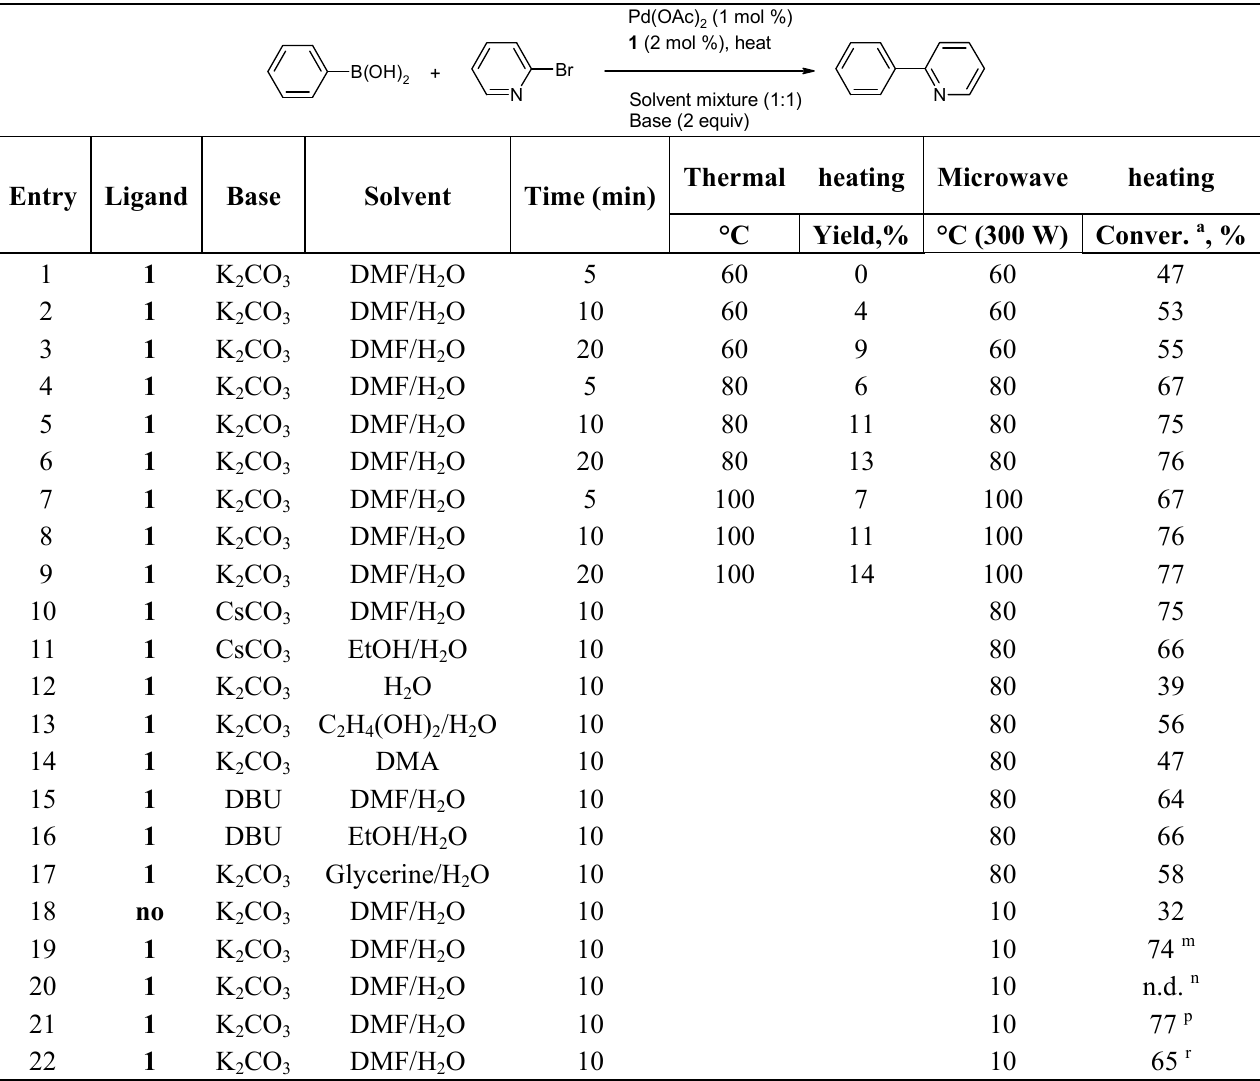
Table 3. Test experiments for optimization of the Suzuki-Miyaura coupling reactions.